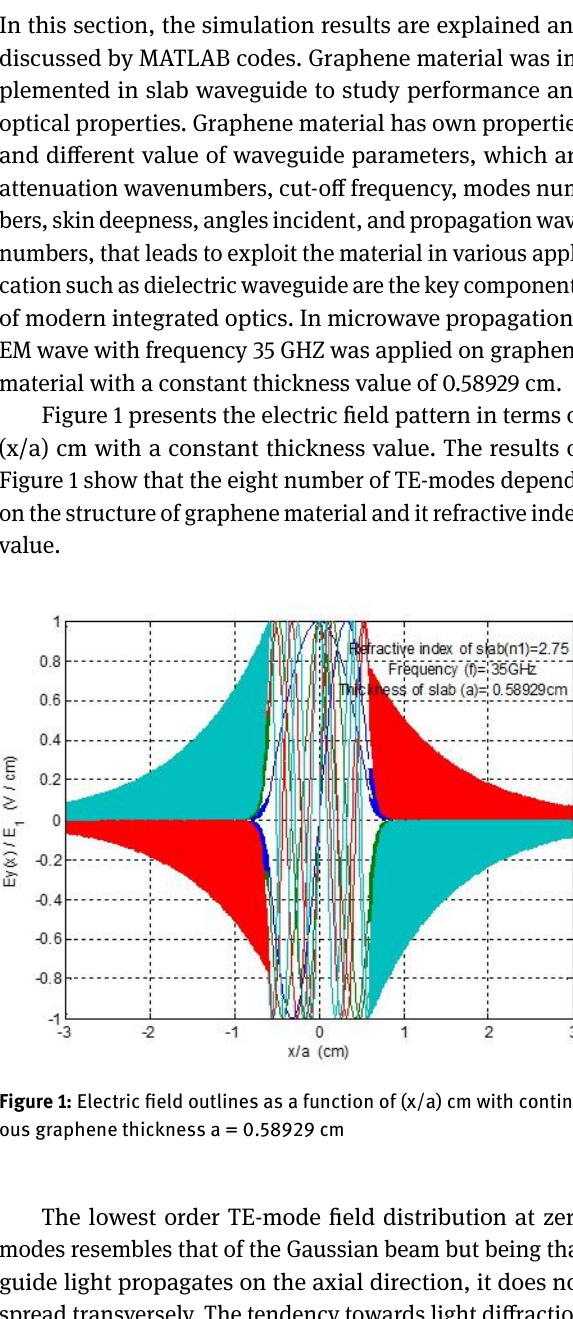
The lowest order TE-mode field distribution at zero modes resembles that of the Gaussian beam but being that guide light propagates on the axial direction, it does not spread transversely. The tendency towards light diffraction in a waveguide is compensated by the medium’s guiding action. Figure 2 shows the lowest mode (m=0) has a maxi- mum intensity at the center and moves along thickness of graphene with higher propagation wave number from the cut-off frequencies of the TE modes. Note that fc1=0, so the lowest order mode propagates at any frequency. There is a propagation evanescent wave in the near the